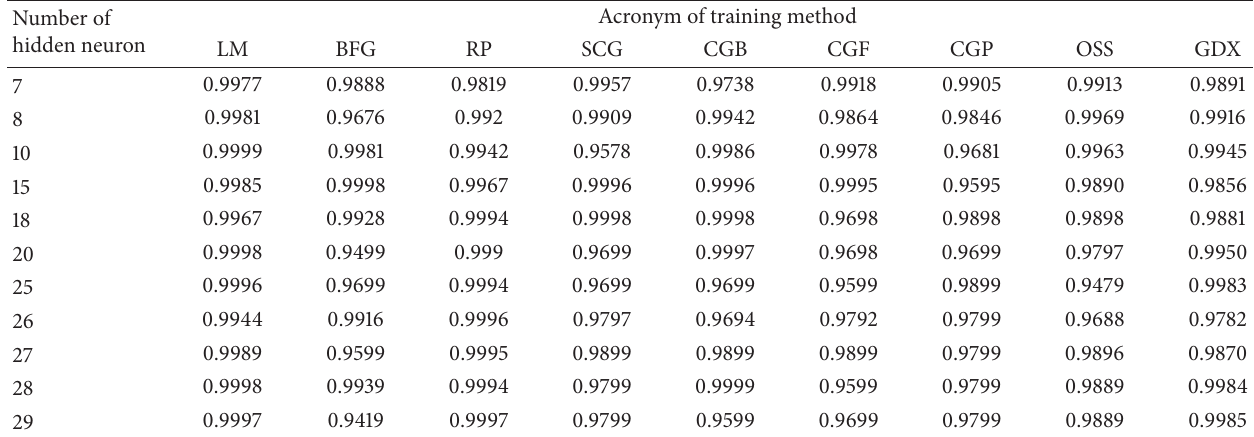
Table 5: The ( 𝑅 2 ) values for PID gain parameters with various neurons in the hidden layer.